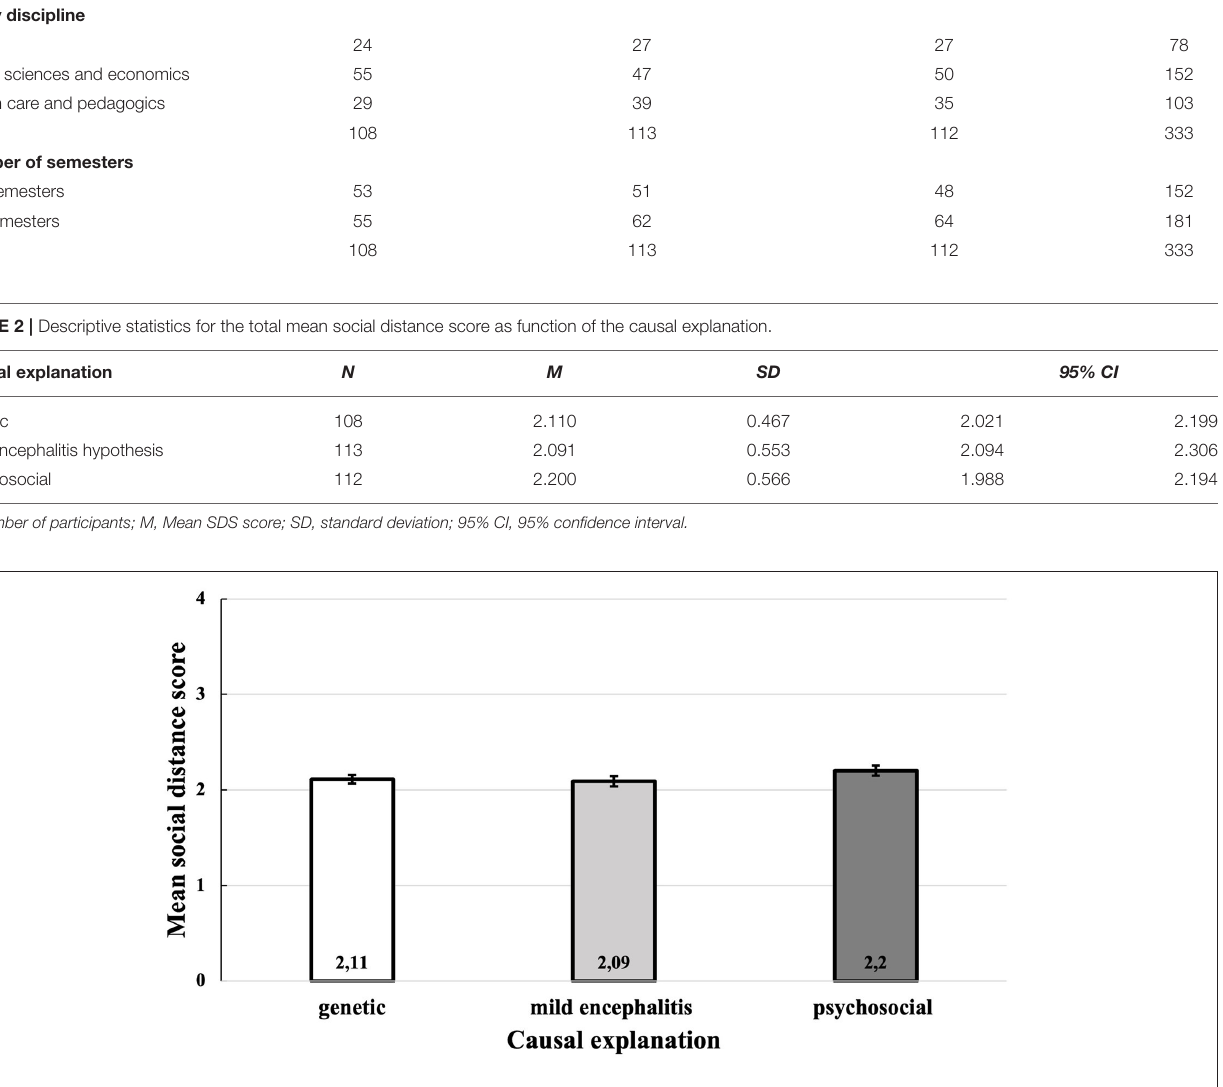
FIGURE 2 | Mean social distance score as a function of the causal